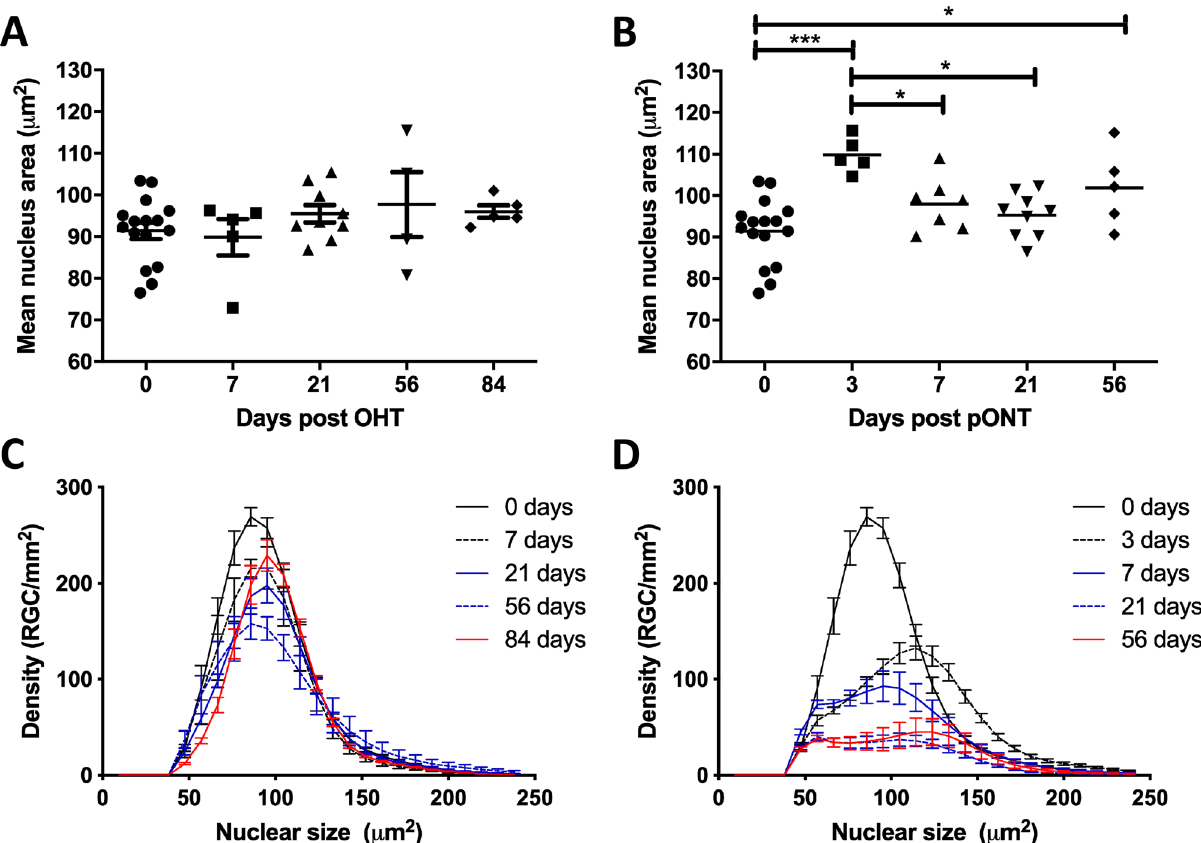
Figure 2. The distribution of RGC nucleus area changes over the course of the OHT ( A , C ) and pONT ( B , D ) models. ( A ) Average RGC nucleus area does not significantly change over the course of the OHT model. ( B ) However, a significant increase in nuclear area is observed 3 days after pONT induction, followed by a reduction in area from 7 days post pONT (One-way ANOVA, Tukey post-hoc test, *p < 0.05, ***p < 0.001). Data points represent individual animals, to illustrate inter-animal variability. ( C , D ) Overall, the RGC density declines and the distribution of RGC density by nucleus area shifts to the right over the course of the ( C ) OHT model and ( D ) pONT models, although this trend is more subtle in the OHT